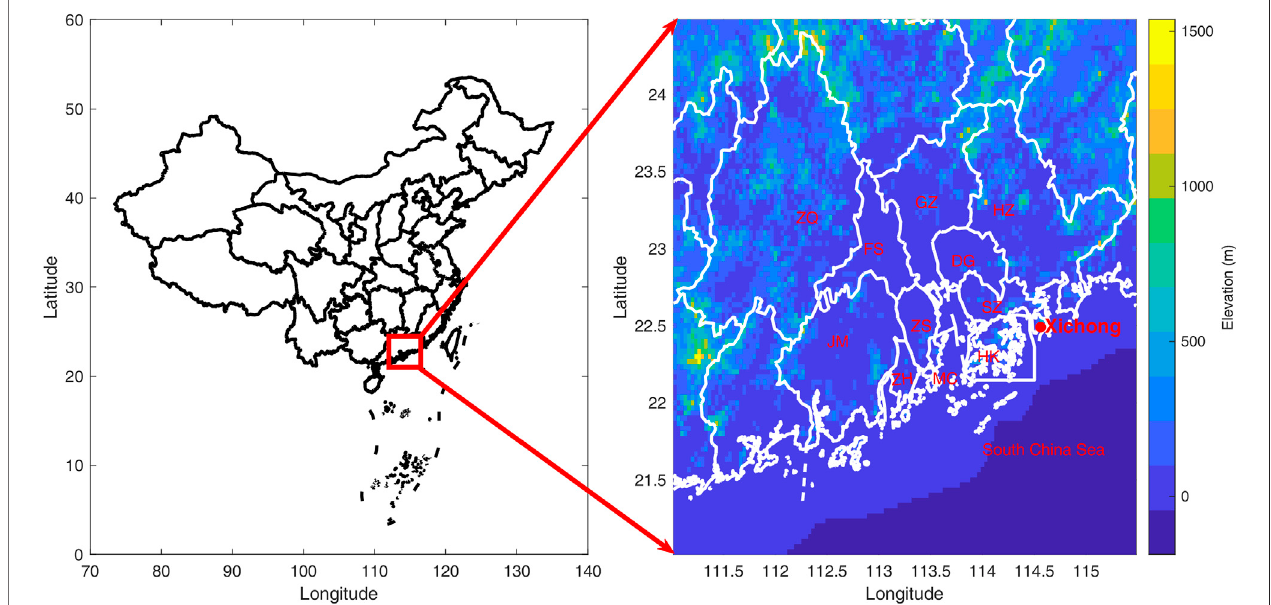
FIGURE1| Topography map ofthe Pearl RiverDelta region with11cities[Zhaoqing(ZQ),Guangzhou (GZ), Huizhou(HZ), Foshan (FS), Dongguan (DG), Jiangmen (JM), Zhongshan (ZS), Shenzhen (SZ), Hong Kong (HK), Zhuhai (ZH), and MC (Macau)] and the location of the Xichong site.